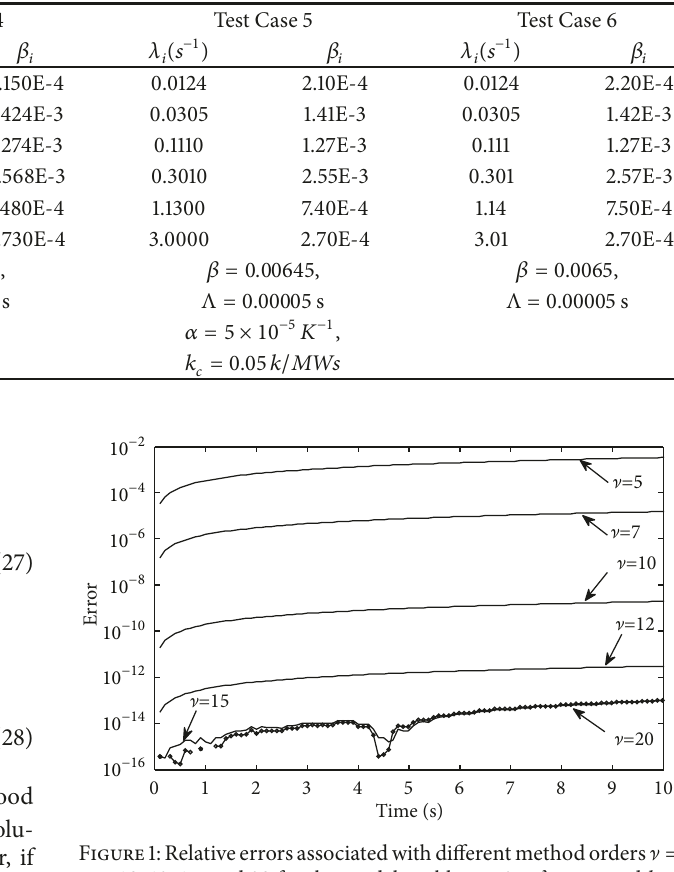
Table 1: Six precursor group parameters for the test cases considered.